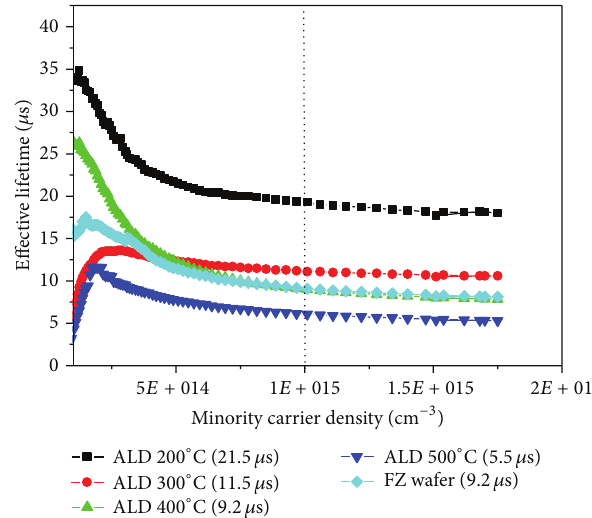
Figure 5: Effective minority carrier lifetime as function of carrier density at different deposition temperatures and their lifetime values at injection level 1 × 10 15 cm −3